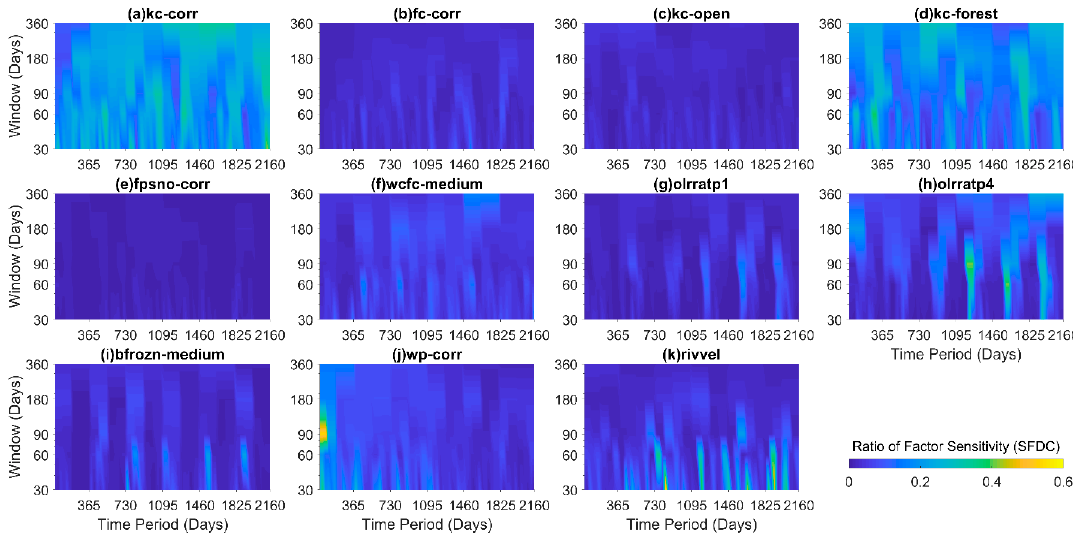
Figure 10. Ratio of factor sensitivity for moving windows of 30 days, 60 days, 90 days, 180 days and 360 days using slope of the flow duration curve ( SFDC ) as the evaluation criteria from 01/01/2000 to 29/11/2005.